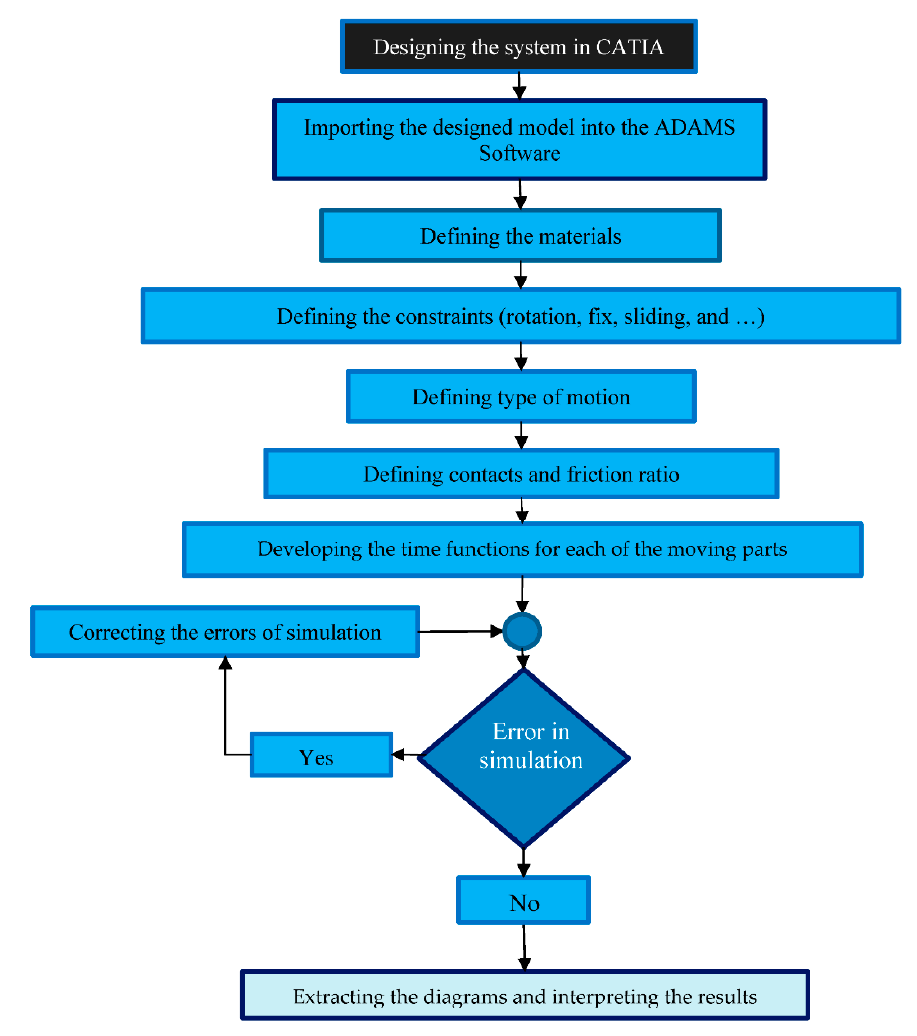
Figure 11. Simulation steps in Automated Dynamic Analysis of Mechanical Systems (ADAMS) software for dynamic analyses of the trout-processing system.